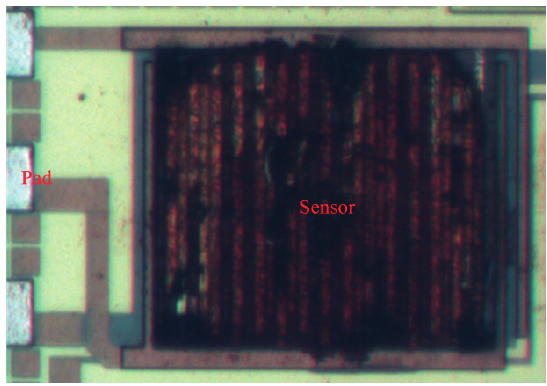
Figure 8. Optical image of the ethanol sensor after the